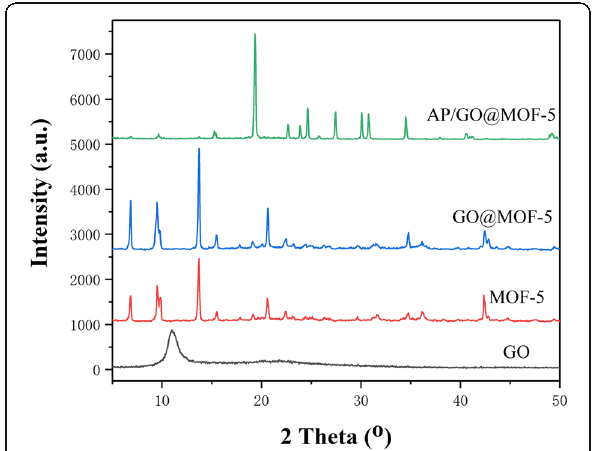
Fig. 3. XRD curves of